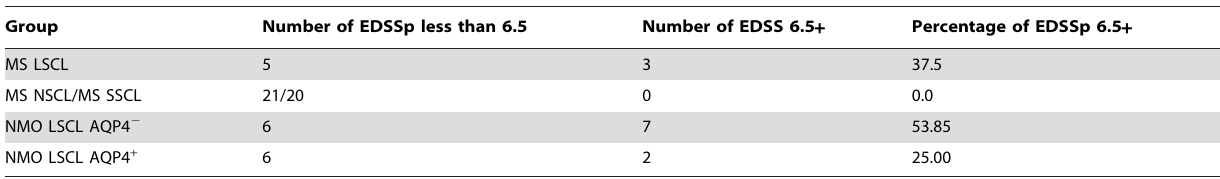
Table 5. Percentage of EDSSp 6.5 + by